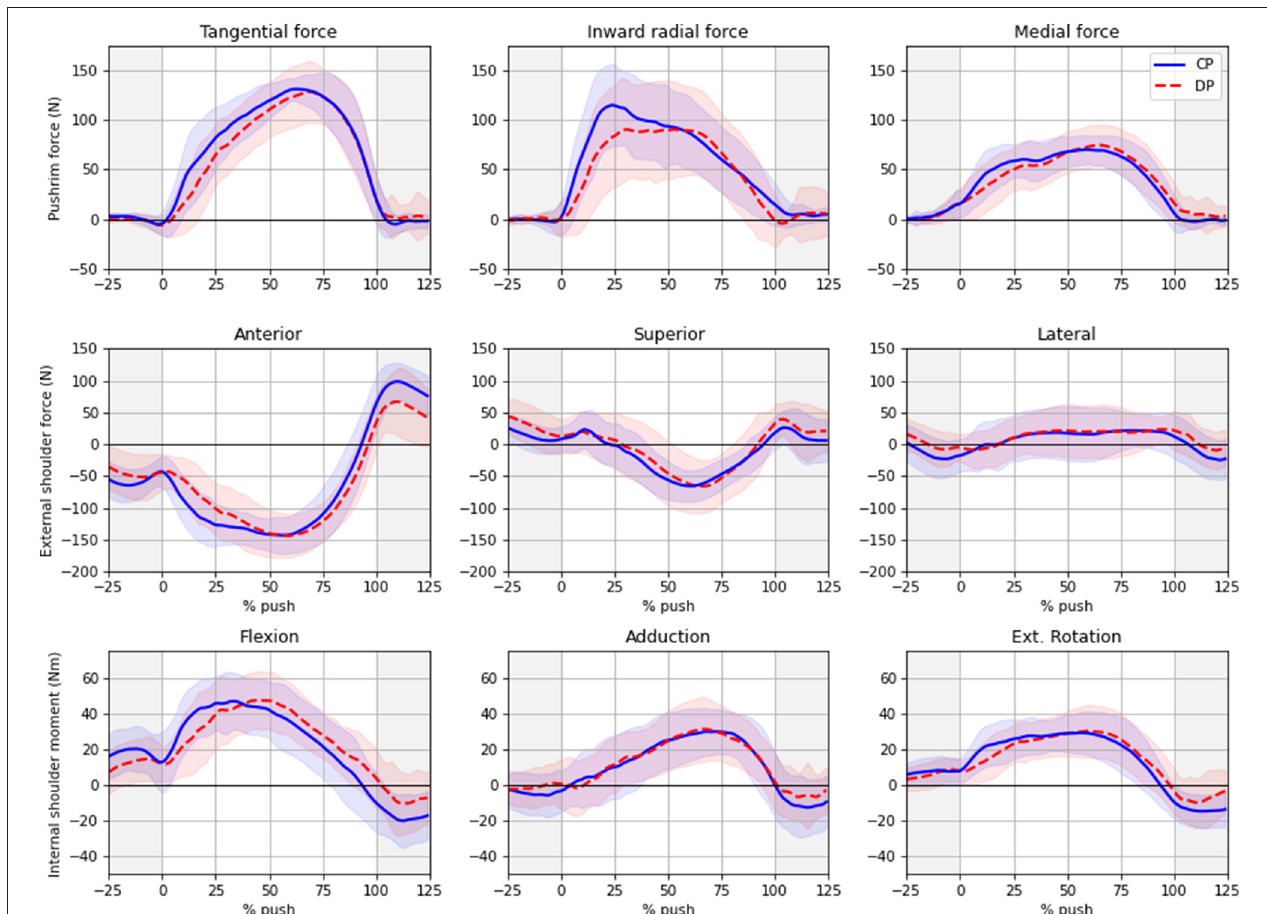
FIGURE 2 | Kinetic profiles during CP and DP